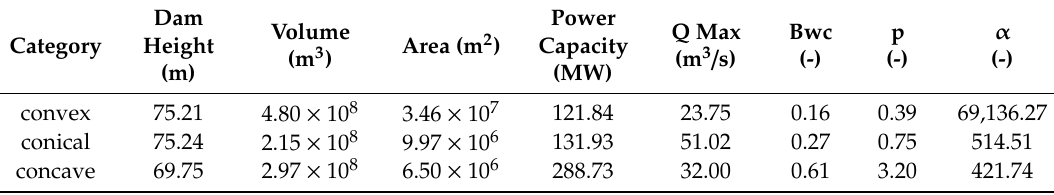
Figure 7. Morphometric characteristics of the studied reservoirs: ( a ) Bwc parameter reservoir distribution; ( b ) p parameter reservoir distribution; ( c ) relationship between the morphometry p coe ffi cient and the Bwc parameter; ( d ) power regression between the maximum surface area and the maximum volume of the reservoir; and ( e ) power regression between the product of the maximum surface area and maximum depth and the maximum volume of water. Table 2. Reservoir categorization and their average morphometric